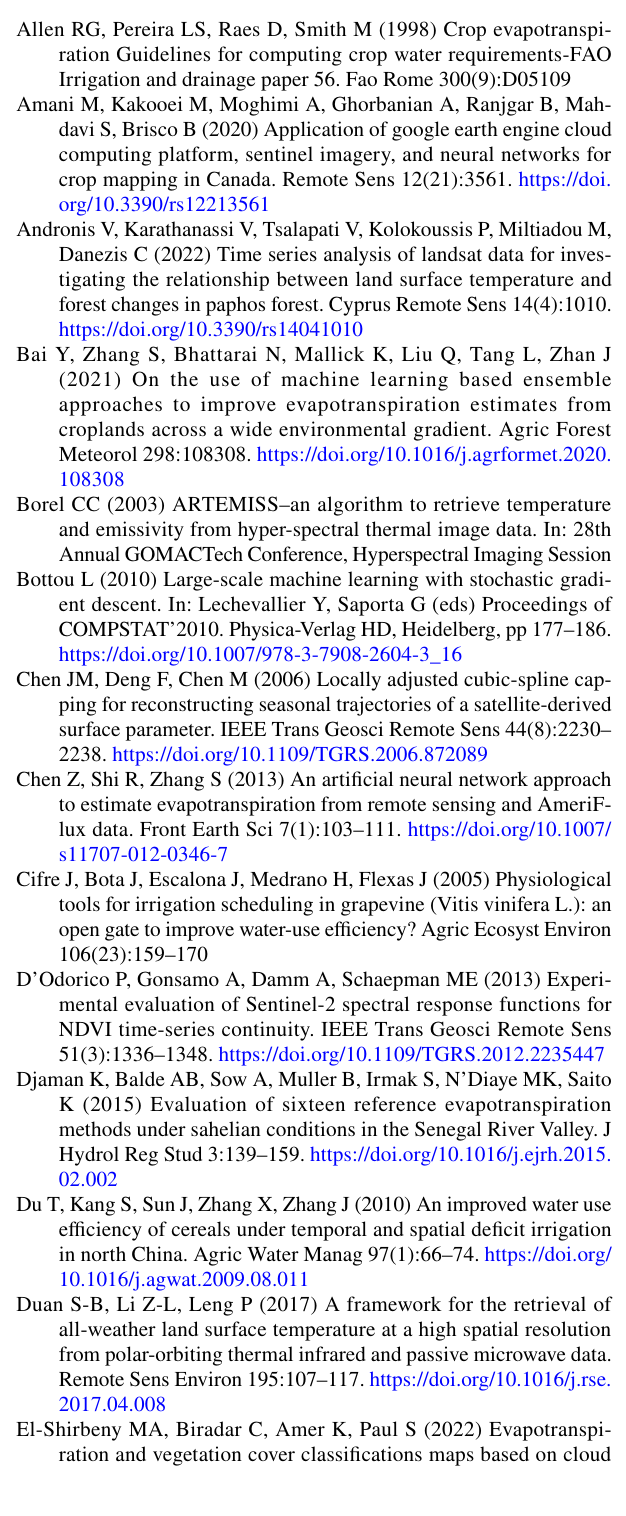
coefficient of input parameters with FAO-PM ET